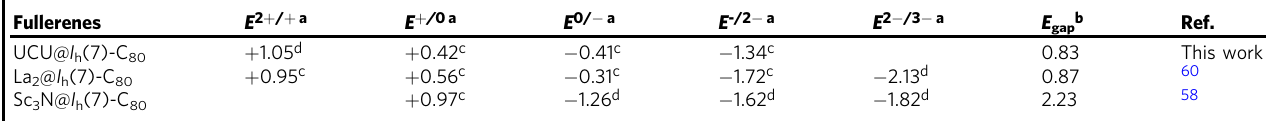
Table 2 Redox potentials and electrochemical gaps of UCU@ I h (7) – C 80 , La 2 @ I h (7) – C 80 , and Sc 3 N@ I h (7) – C 80 Fullerenes